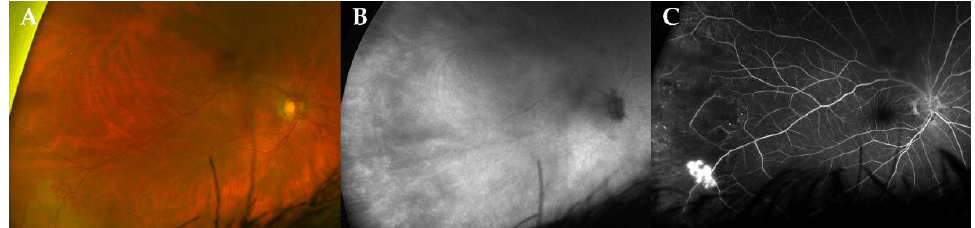
Figure 2. Multimodal imaging of a peripheral retinal neovascularization in a patient with stable disease. Ultra-widefield (UWF) fundus photography (CF, panel ( A )), indocyanine green angiography fundus imaging (ICG, panel ( B )) and fluoresceine angiography (FA, panel ( C )) of a 72-year-old male patient (case 3) at 86 months of follow-up. Note the active retinal neovascularization in the temporal periphery. In this case, the use of ICG could not demonstrate a choroidal lesion.